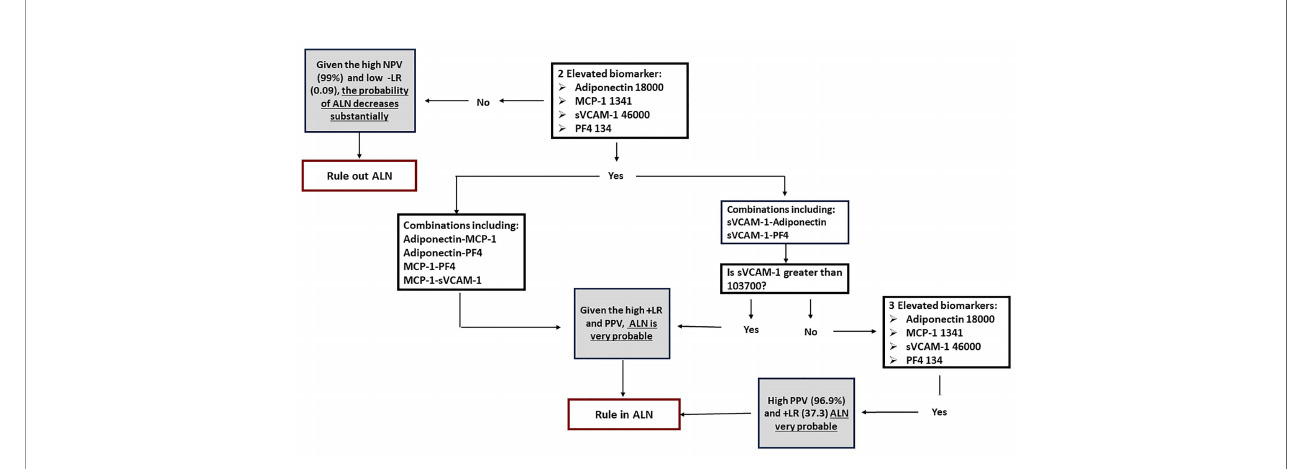
FIGURE 3 | Proposed 2 step approach for the detection of ALN